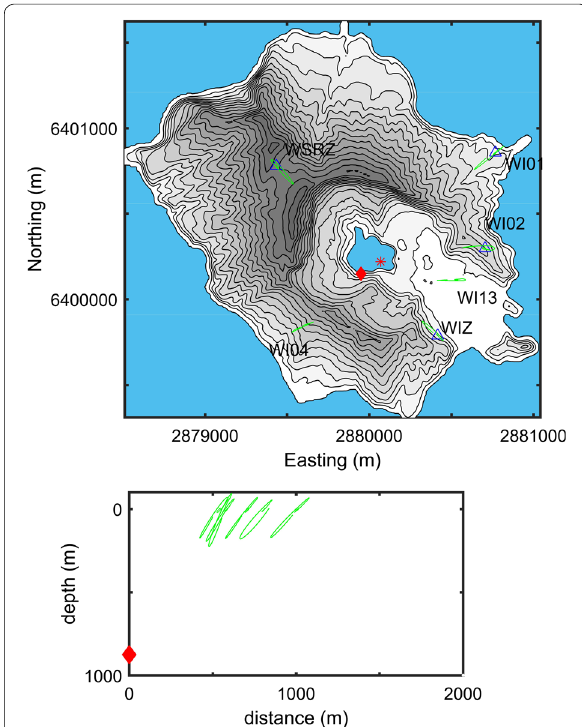
Fig. 3 Waveform particle motions for 1-min window beginning at 09:53:00 UTC marking the onset of VLP recorded just prior to eruption P4 (see Fig. 2c). The cross-section shows the particle motions from the projection of the radial component with depth for each individual seismogram. The star is the active vent from the 2013 mud/sulphur eruption activity and the diamond is the best fit